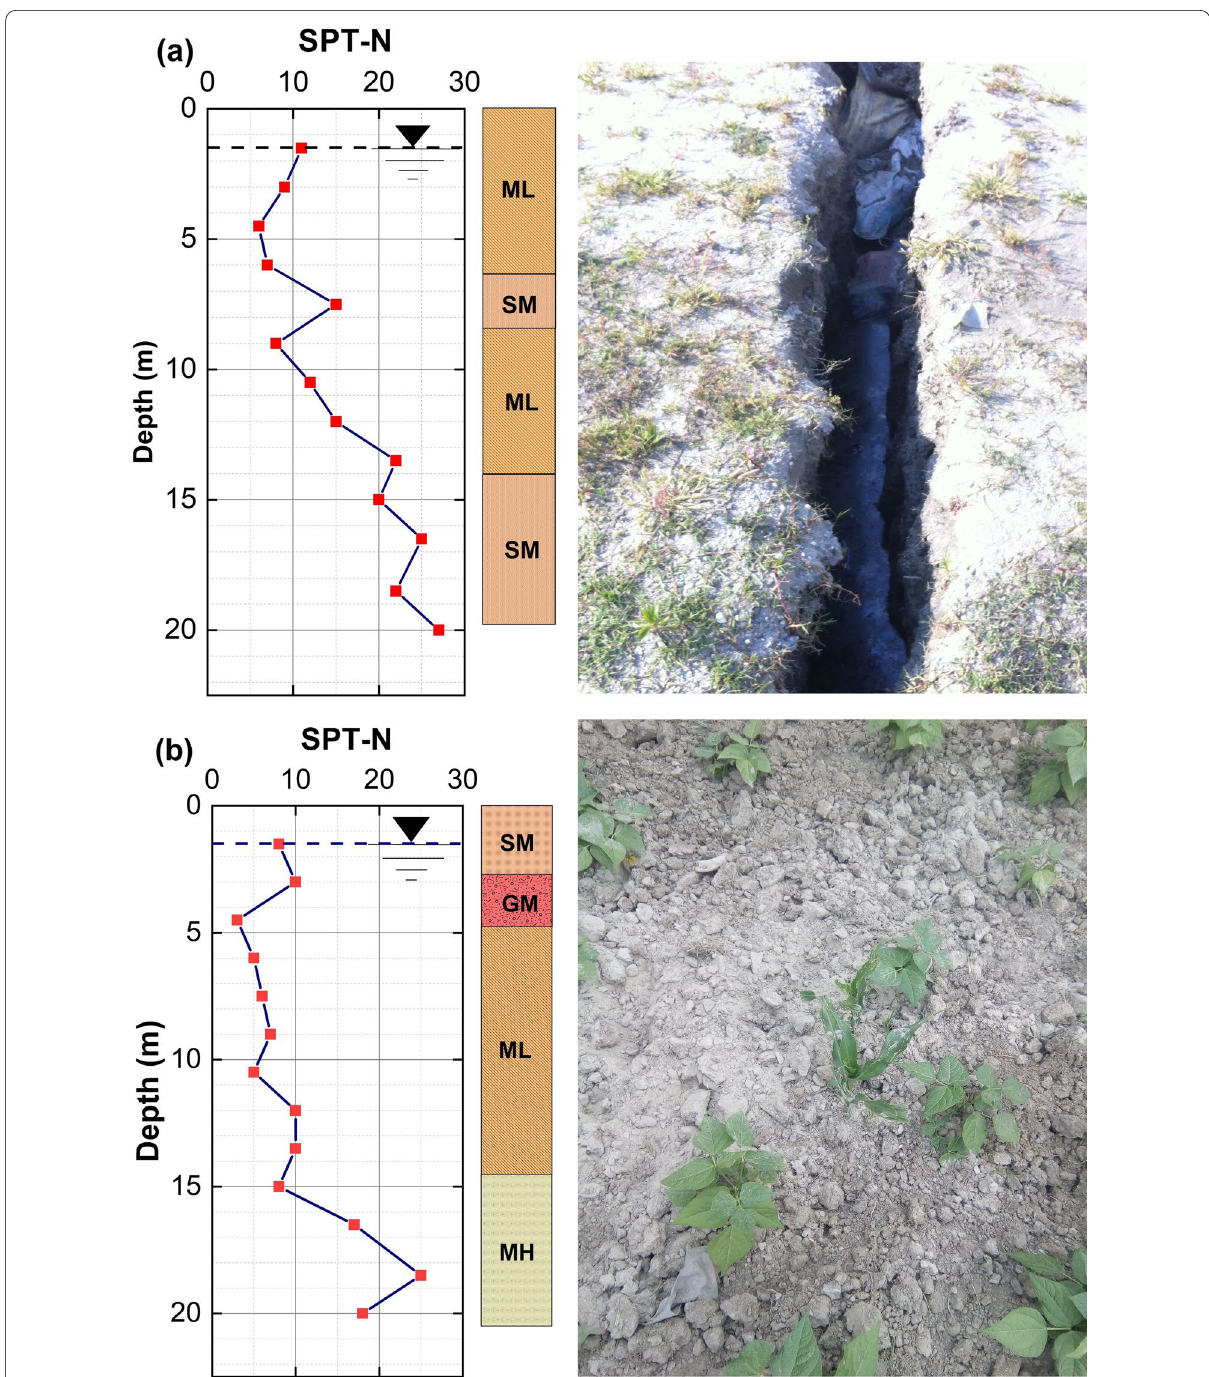
Fig. 2 Typical borehole logs and observed liquefaction during the 2015 Gorkha Earthquake at a Manamaiju (27.7453° N, 85.3007° E) and b Imadol (27.6668° N, 85.3383° E) (refer Fig. 1 for the site